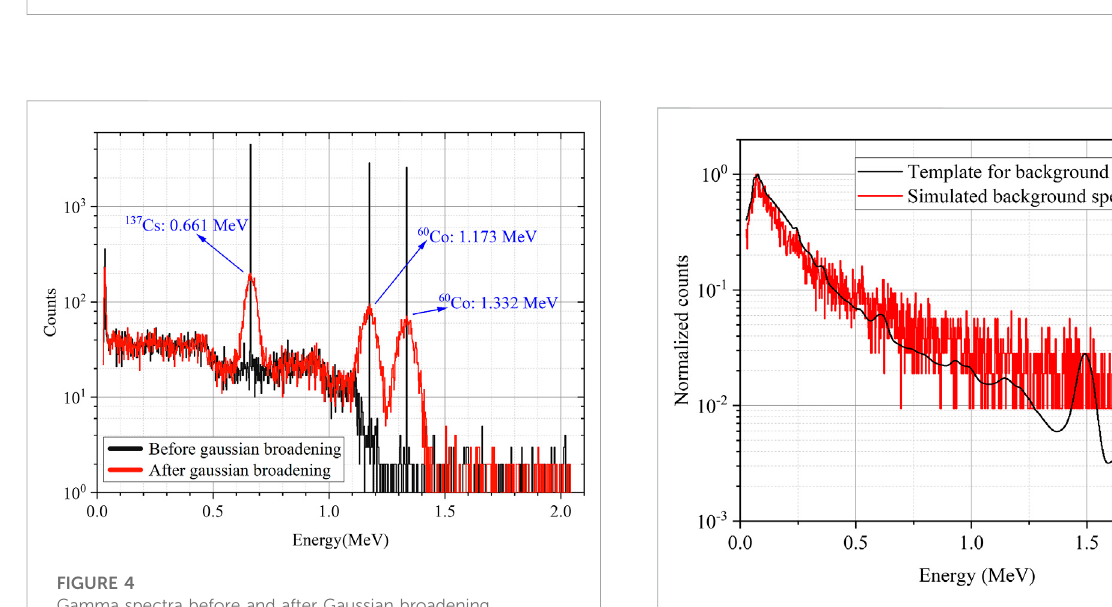
FIGURE 3 Detector model established with Geant4.